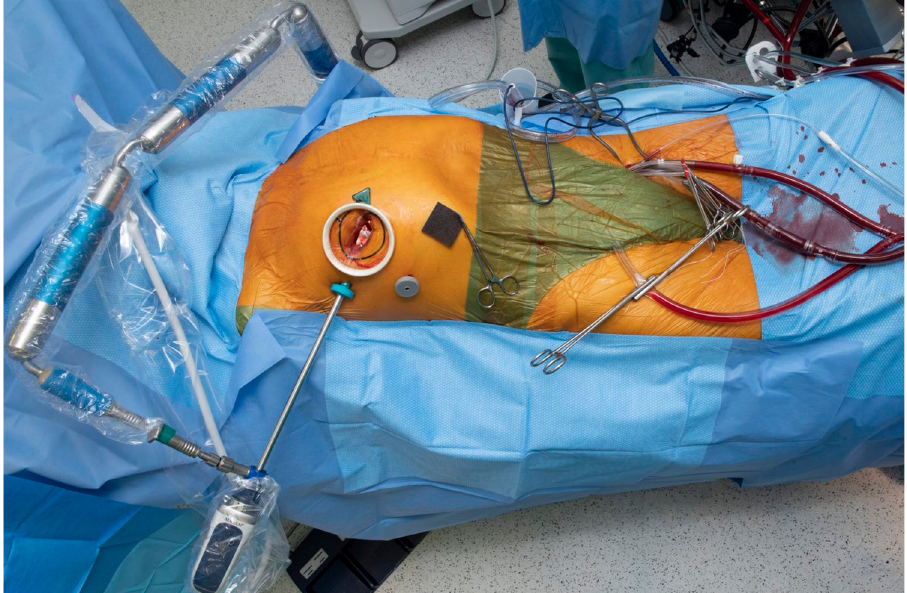
Figure 2. Full cannulation setup. Of note, this case was done on a beating heart with a single venous cannula and no additional shunting or occlusion devices. Furthermore, a ‘Y’ arterial connection is routinely constructed to facilitate additional arterial cannulation if need be (doubly clamped arterial connection at the bottom of the image). The camera holder is a pneumatically operated arm which can be seen at the top of the image.